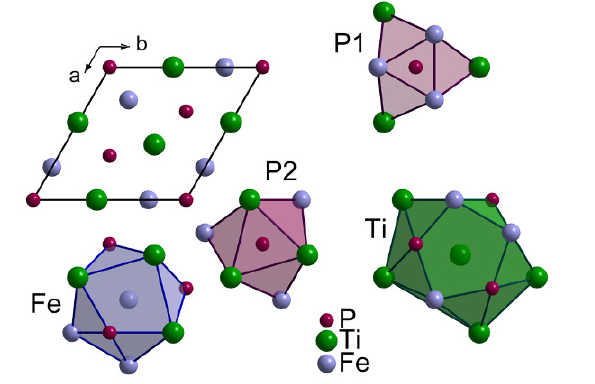
Fe P 4.6 0.4 3.16